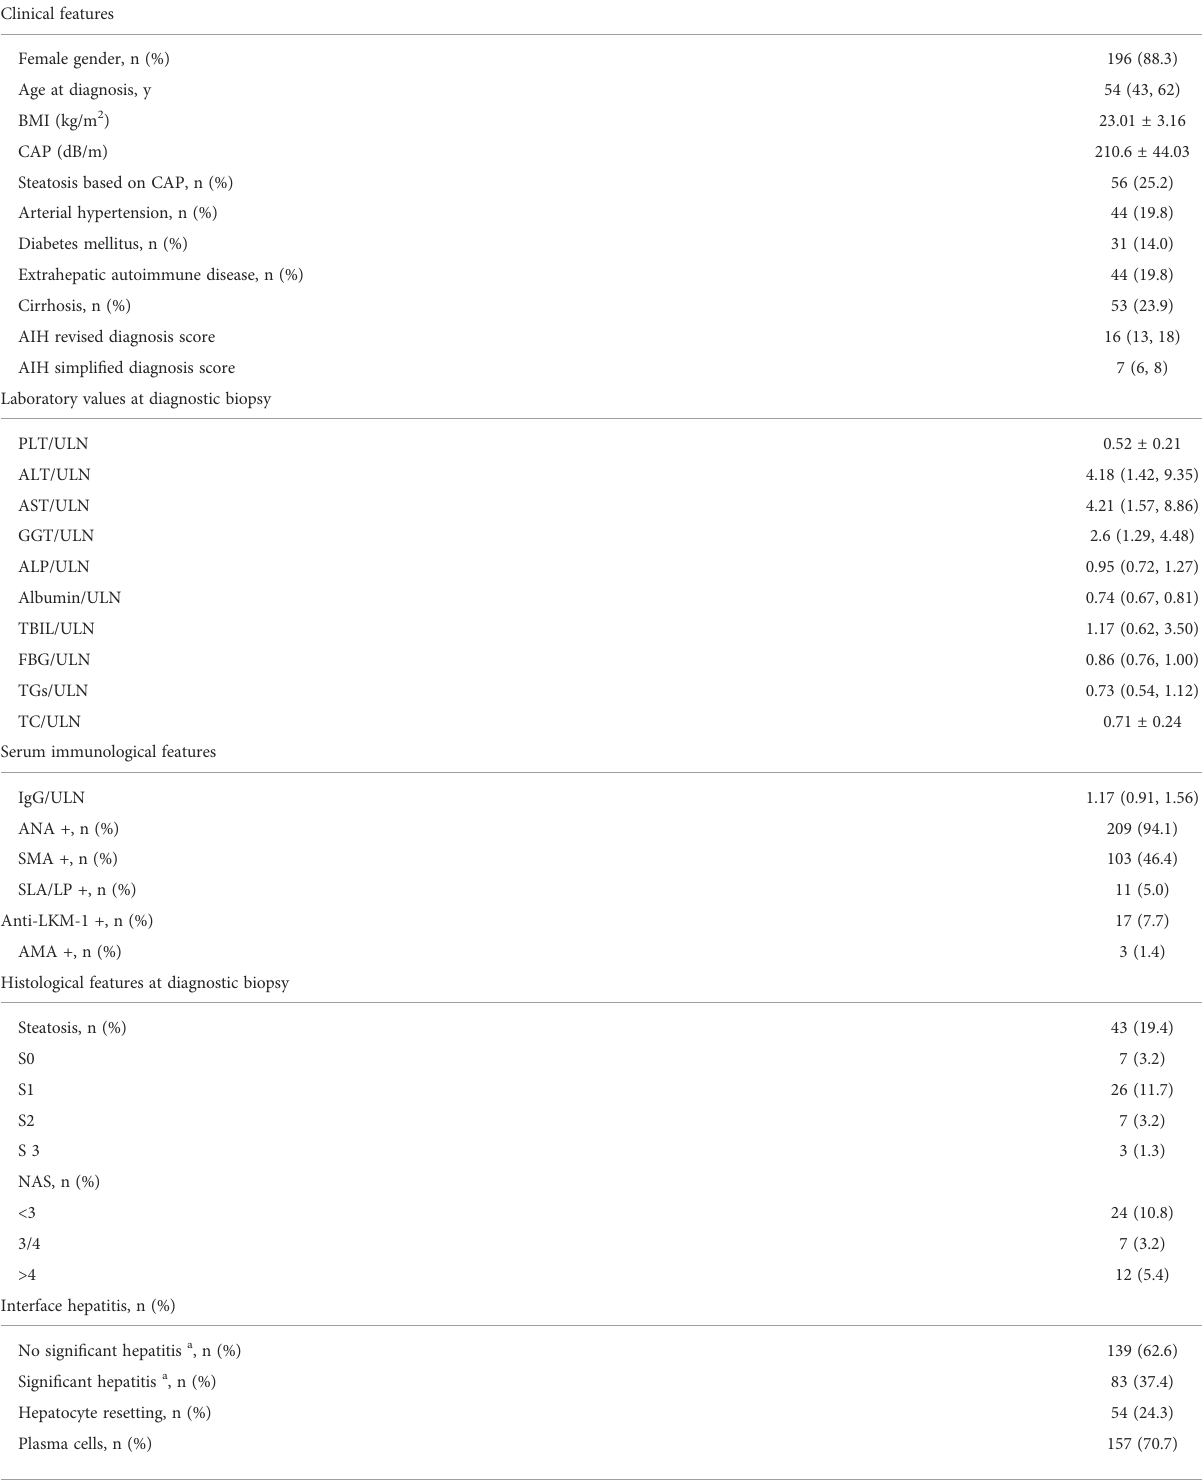
TABLE 1 Clinical, biochemical, immunological and histological features of patients at